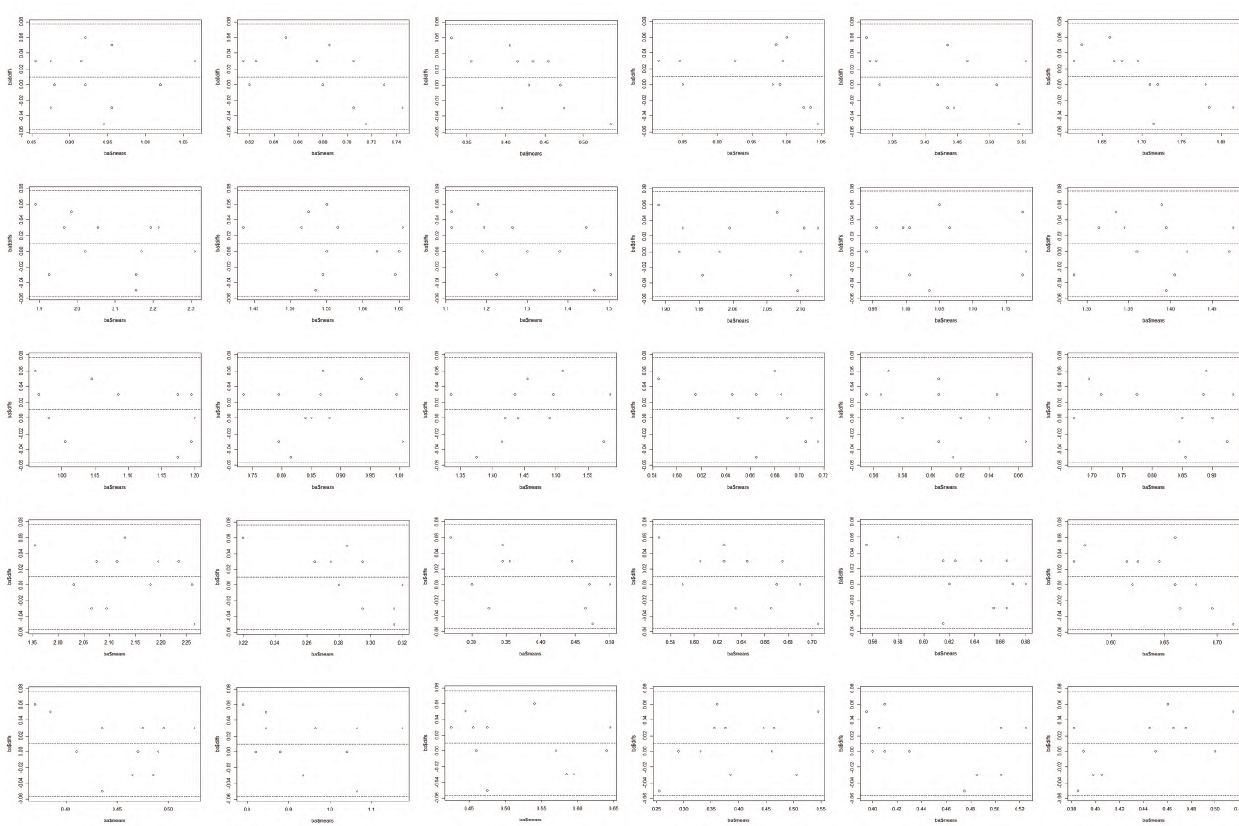
Figure 4. Supplementary data: Bland-Altman plots for bleb area measurement between two graders for all eyes included in this study under different lighting